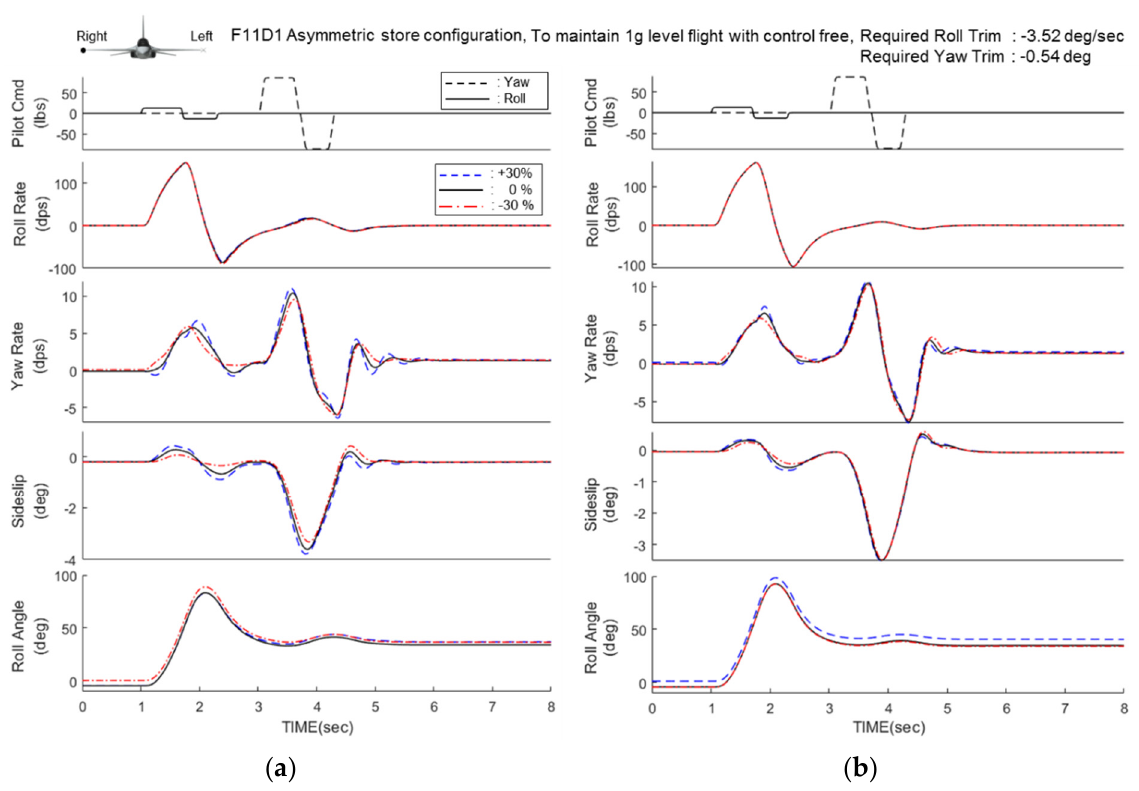
(cid:4593) control effectiveness uncertainties ( ± 30%) in M0.8, 20 (cid:3293) δ r (cid:3293)